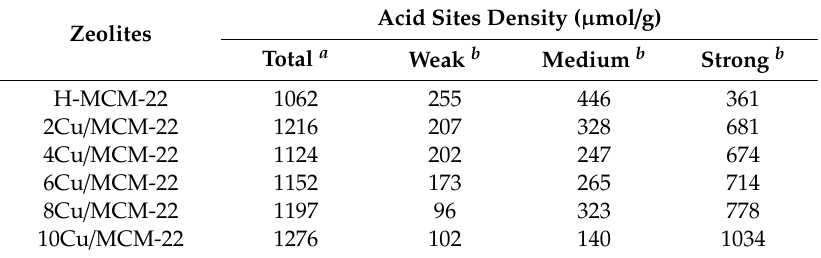
Table 2. Quantitative results of acid densities in H-MCM-22 and x Cu / MCM-22 zeolites. Zeolites